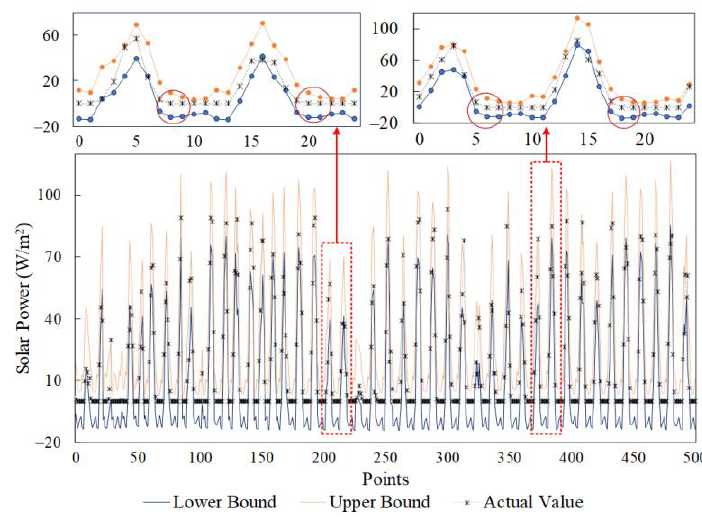
Figure 4. The prediction results obtained by PSO and WI with ELM-AE.